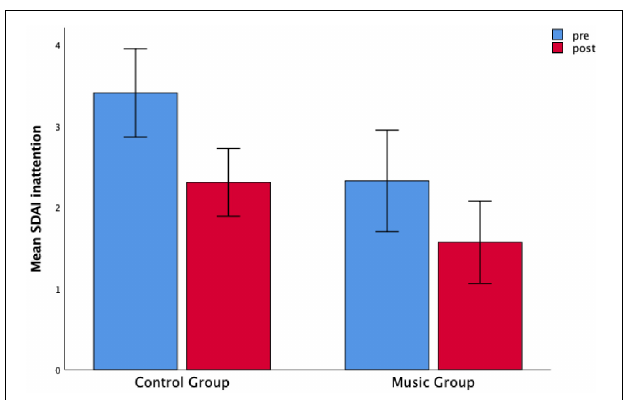
FIGURE 4 | Both the control group and music groups showed a decrease in inattention scores rated by the teachers. Teachers’ mean scores as a function of Time (pre-test and post-test) and Group (music and control). Error bars are standard